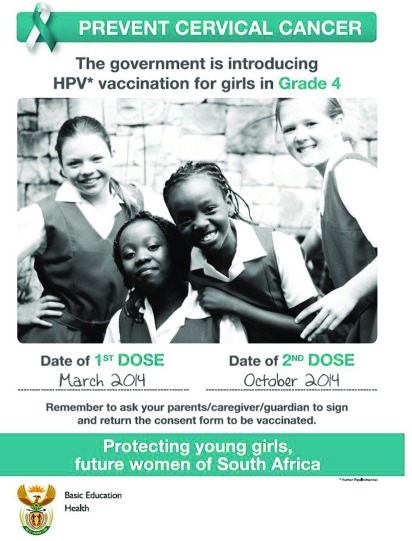
Social Mobilization Poster Distributed by the South African Department of Health During the 2014 HPV Vaccination CampaignAbbreviation: HPV, human papillomavirus